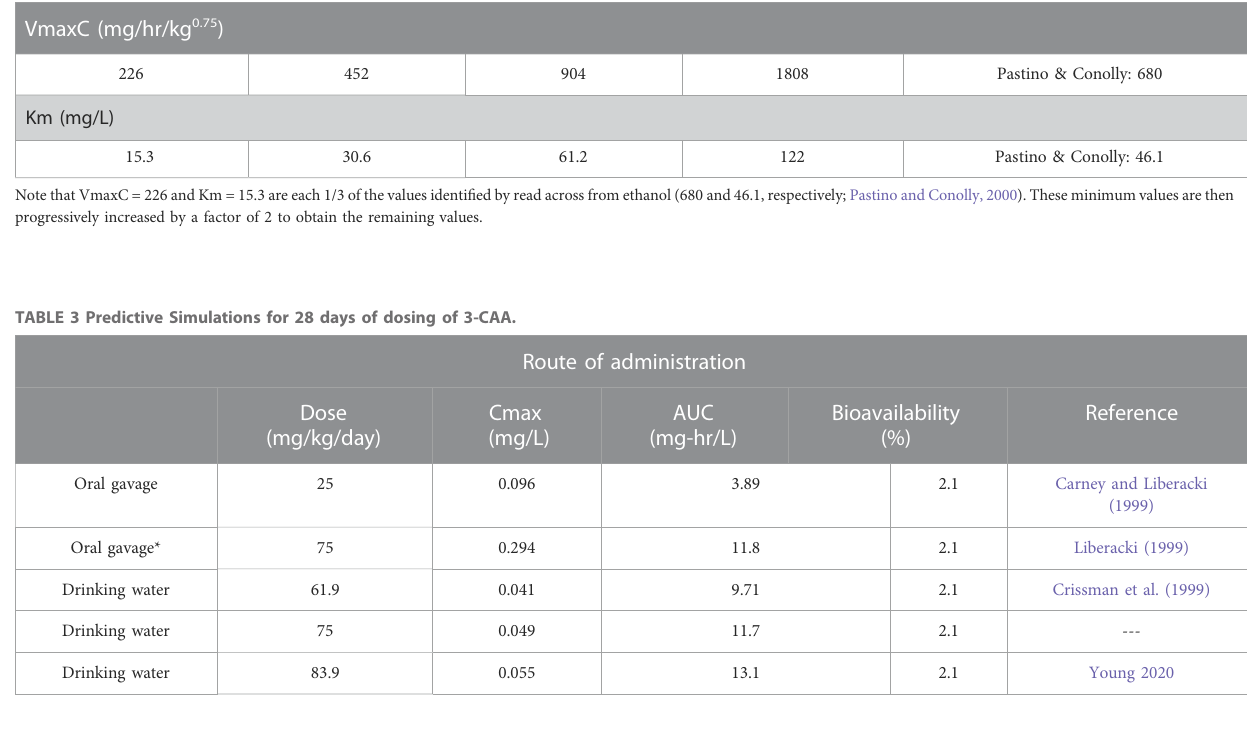
TABLE 2 Metabolic parameters for 3-CAA.